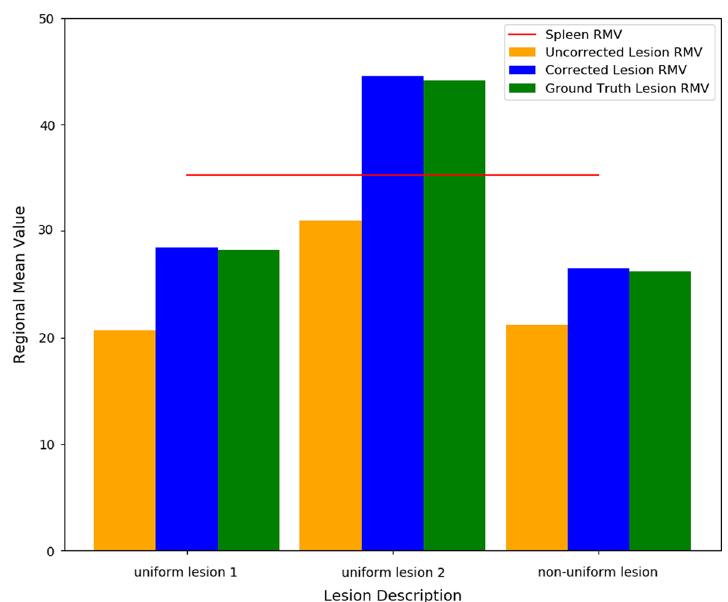
Fig. 10 Regional mean values before and after STC correction, compared with Ground Truth, for noise‑free data and 200 reconstruction updates, for the three different liver lesions investigated within the Tektrotyd XCAT dataset. The value for the spleen is also demarcated with a line demonstrating that the uncorrected RMV of uniform lesion 2 is lower than the spleen, but the ground truth and post‑STC corrected RMV is actually greater than the